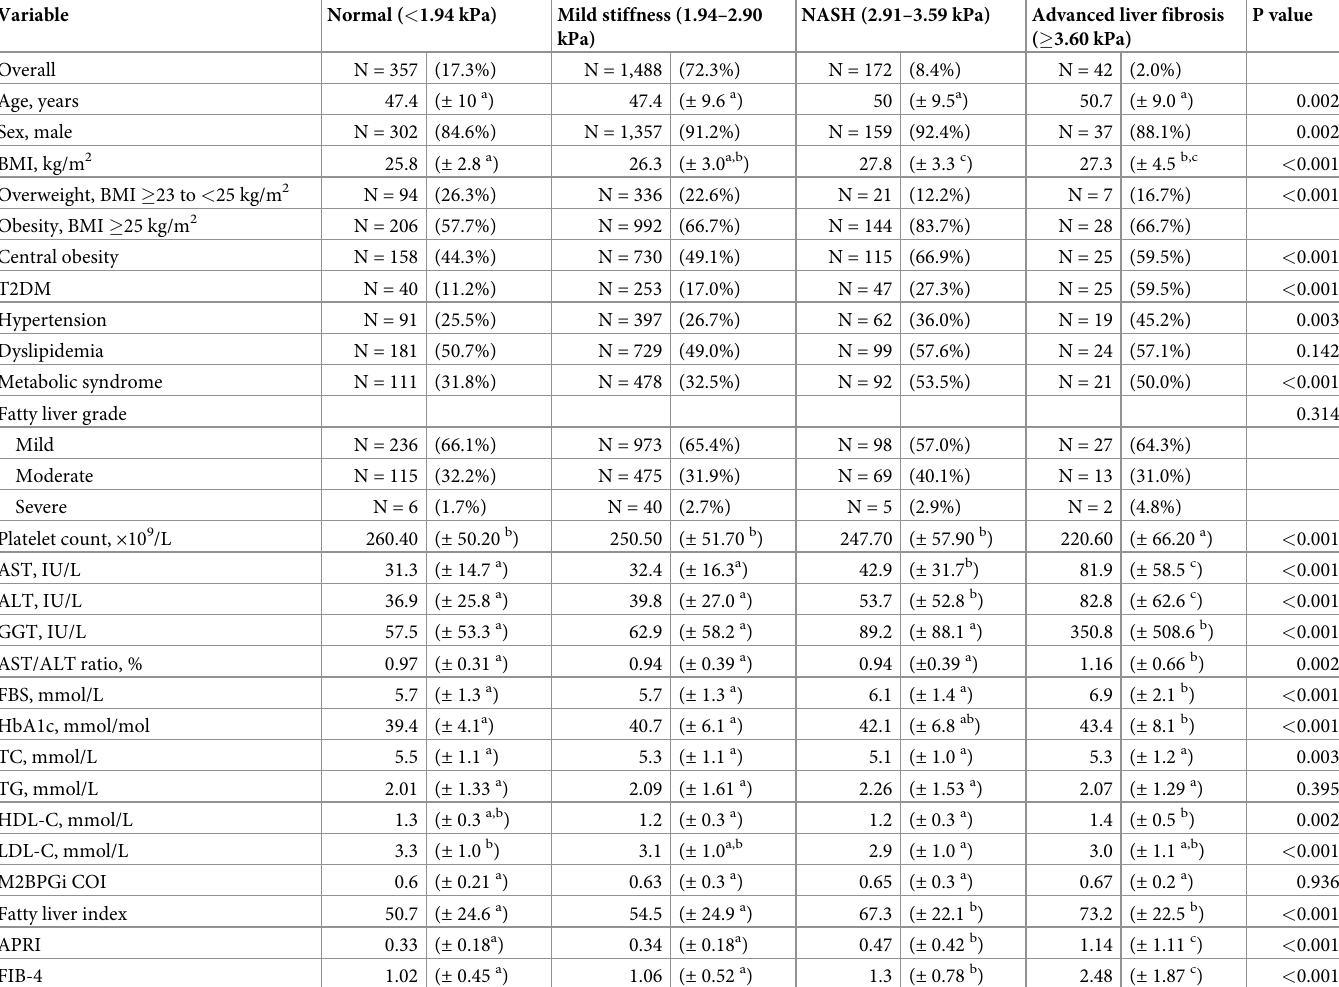
Table 5. Clinical and laboratory characteristics of study subjects according to liver stiffness category using MRE in fatty liver.